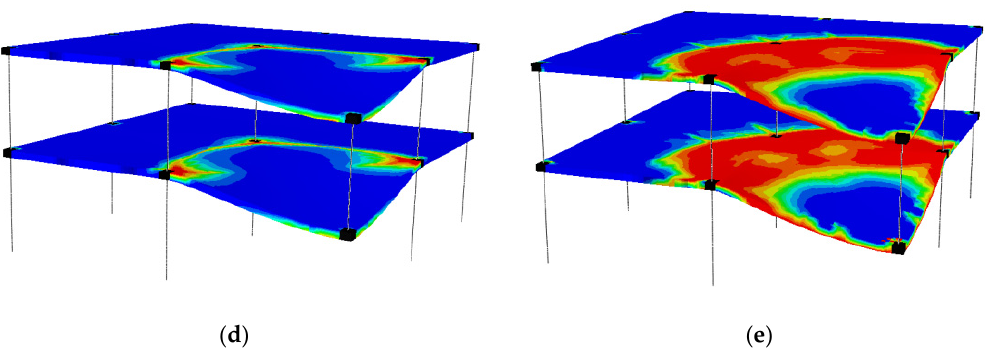
Figure 11. Computed tensile damage at t = 2 s obtained for ( a ) M_fct2.5, ( b ) M_ ρ 0.5, ( c ) M_nf7, ( d ) M_crt0.2 and ( e ) M_q9.